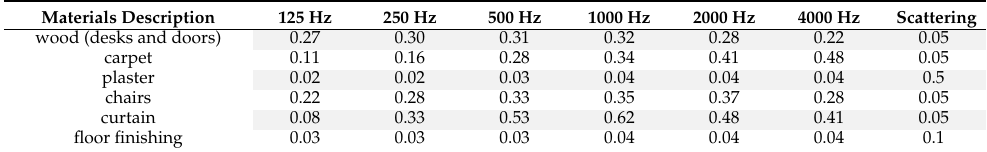
Table 1. The absorption and scattering coefficients of the considered materials.